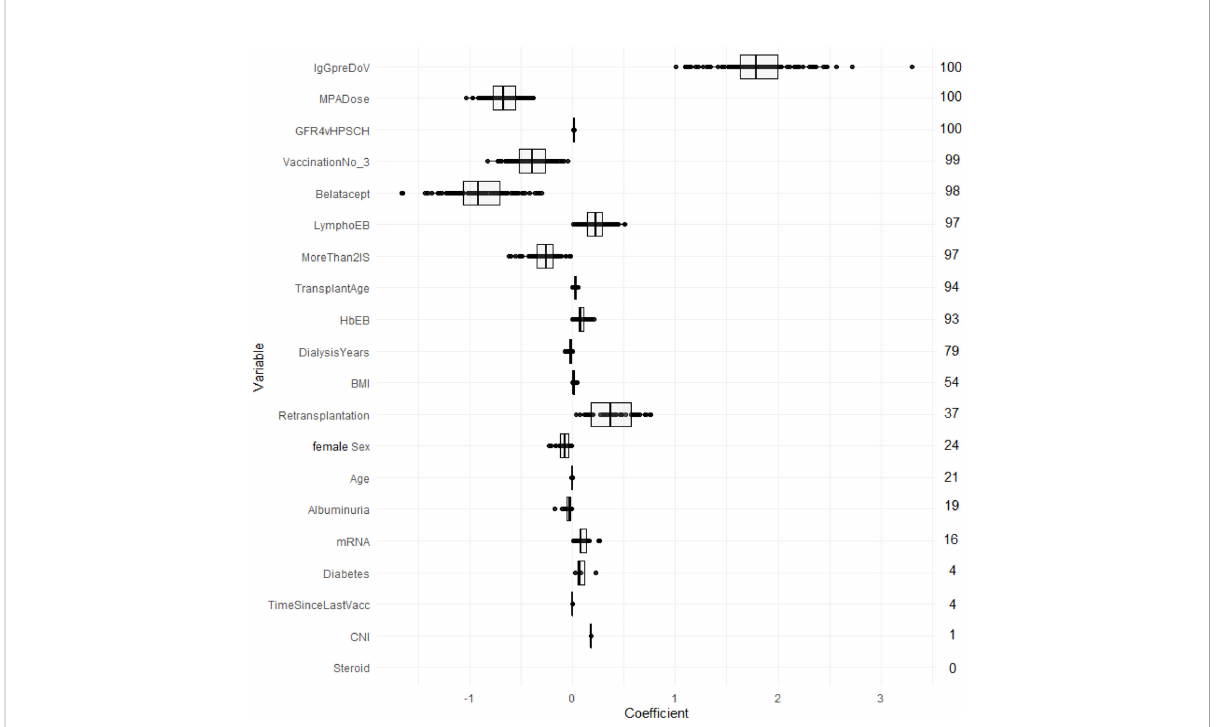
FIGURE 2 Estimated coef fi cients of the LASSO-1SE models summarized across 100 subsampling runs for unstandardized variables. Numbers on the right indicate the selection frequency (in percent) for the respective variable in 100 subsampling runs. Variables are ordered from top to bottom according to the selection